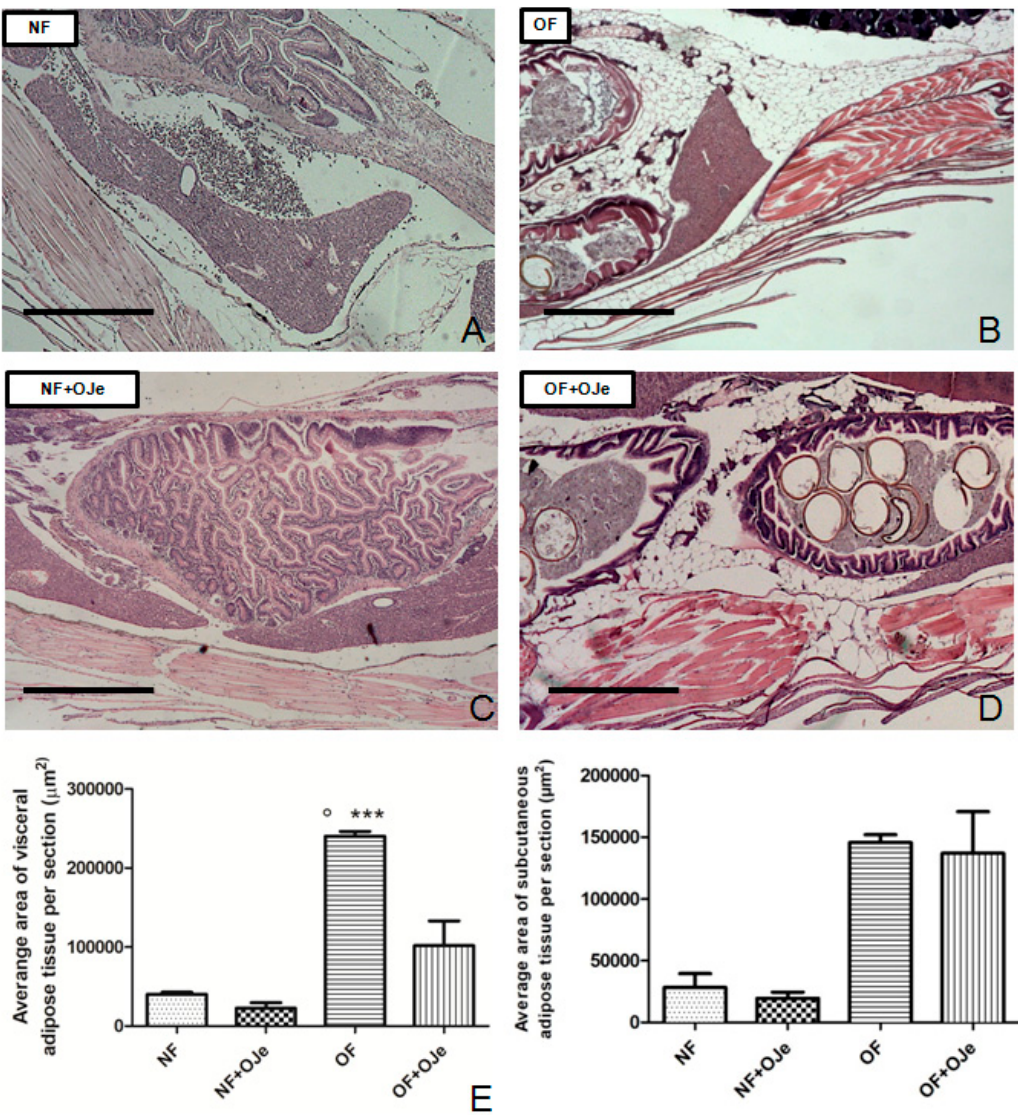
Figure 2. OJe reduced the development of adipose tissue in overfed zebrafish. Histological examination of abdominal tissue of sagittal sections, performed through hematoxylin and eosin staining, showed the rise of visceral ( E ) and subcutaneous ( F ) fat depots in the OF group ( B ) but not in the NF group ( A ). Five weeks of OJe treatment reduced visceral adipose tissue area in OF fish ( D , E ) without affecting the subcutaneous area ( D , F ). The morphometric fat analysis showed that NF fish had no significant changes in either visceral ( C , E ) or subcutaneous ( C , F ) adipose tissue areas. Photos ( A – C ) are representative of that (three per section) taken in 10 fish per group. The values in graphs ( E ) and ( F ) are expressed in µm 2 of adipose tissue per section. Scale bars correspond to 1 mm. Data